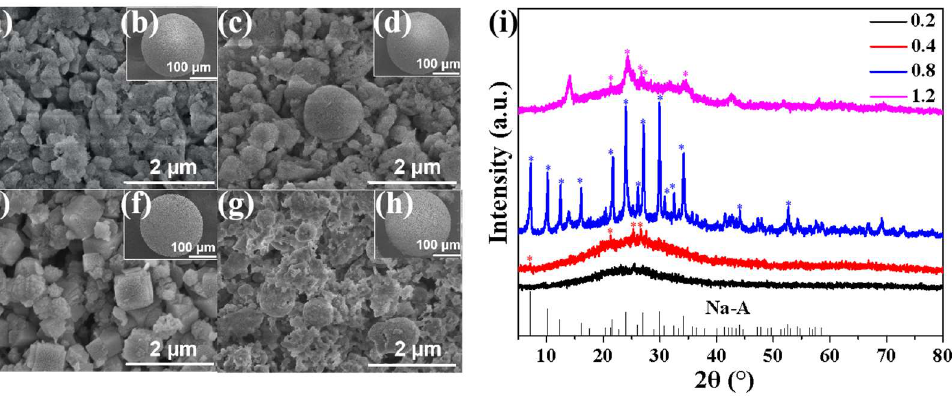
Figure 1. SEM and XRD tests of NMGM with different NaOH additions: ( a , c , e , g ) are the SEM tests of NMGM with Na 2 O/SiO 2 of 0.2, 0.4, 0.8, 1.2, respectively; ( b , d , f , h ) SEM of NMGM with Na 2 O/SiO 2 of 0.2, 0.4, 0.8, 1.2, respectively; ( i ) is the XRD pattern of different Na 2 O/SiO 2 ratios (*: characteristic peaks of NaA molecular sieves).